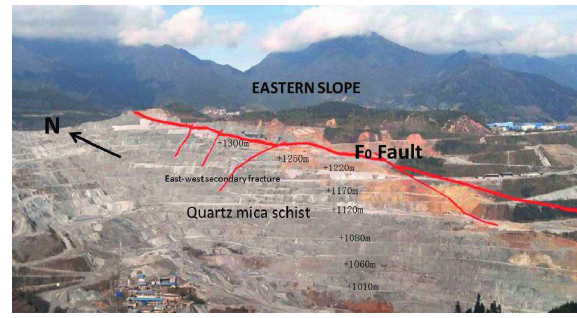
Figure 1: Topography of east